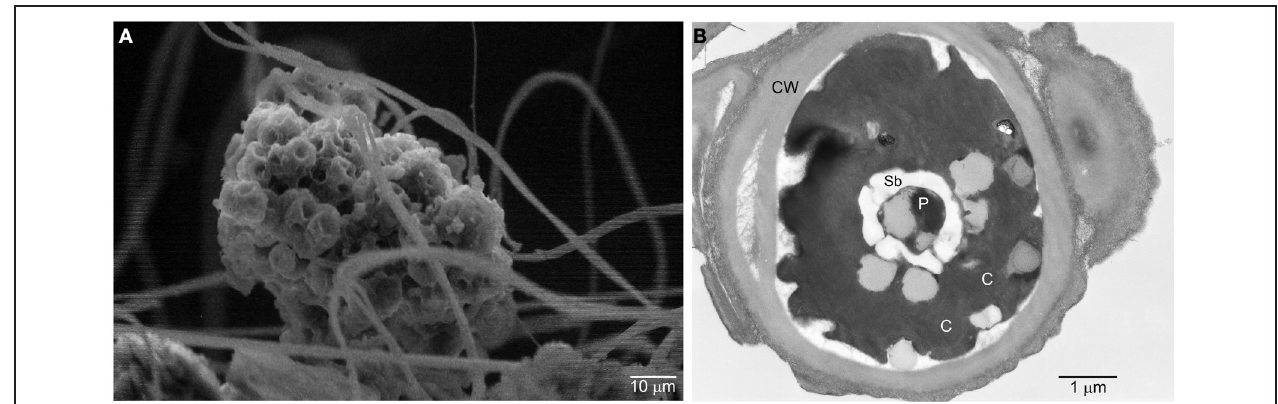
FIGURE 4 | Scanning and transmission electron micrographs of the cave Dunaliella . (A) SEM micrograph of a group of cells of cave Dunaliella attached to the spider web’s silk threads. (B) TEM micrograph of a cave Dunaliella cell. CW, cell wall; C, chlorosplast; P, pyrenoid; Sb, starch bodies.